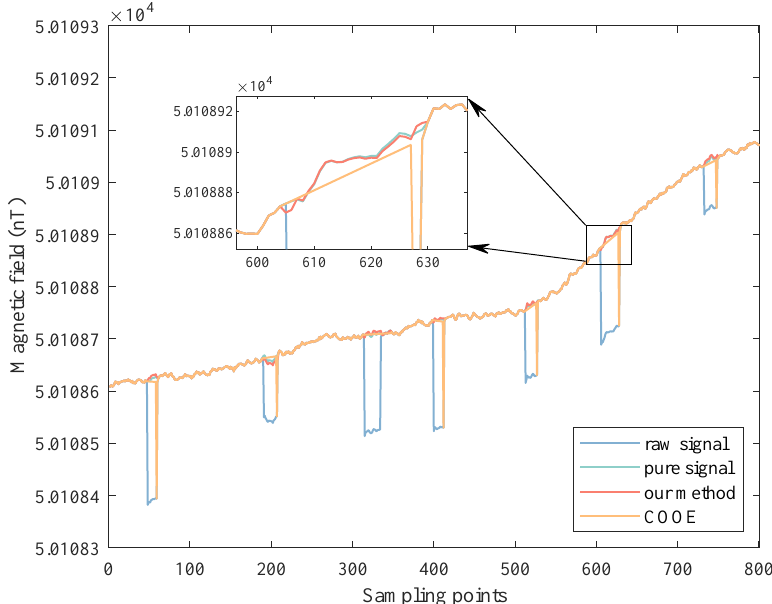
Figure 8. The comparison of repair results in the semi-real data segment.